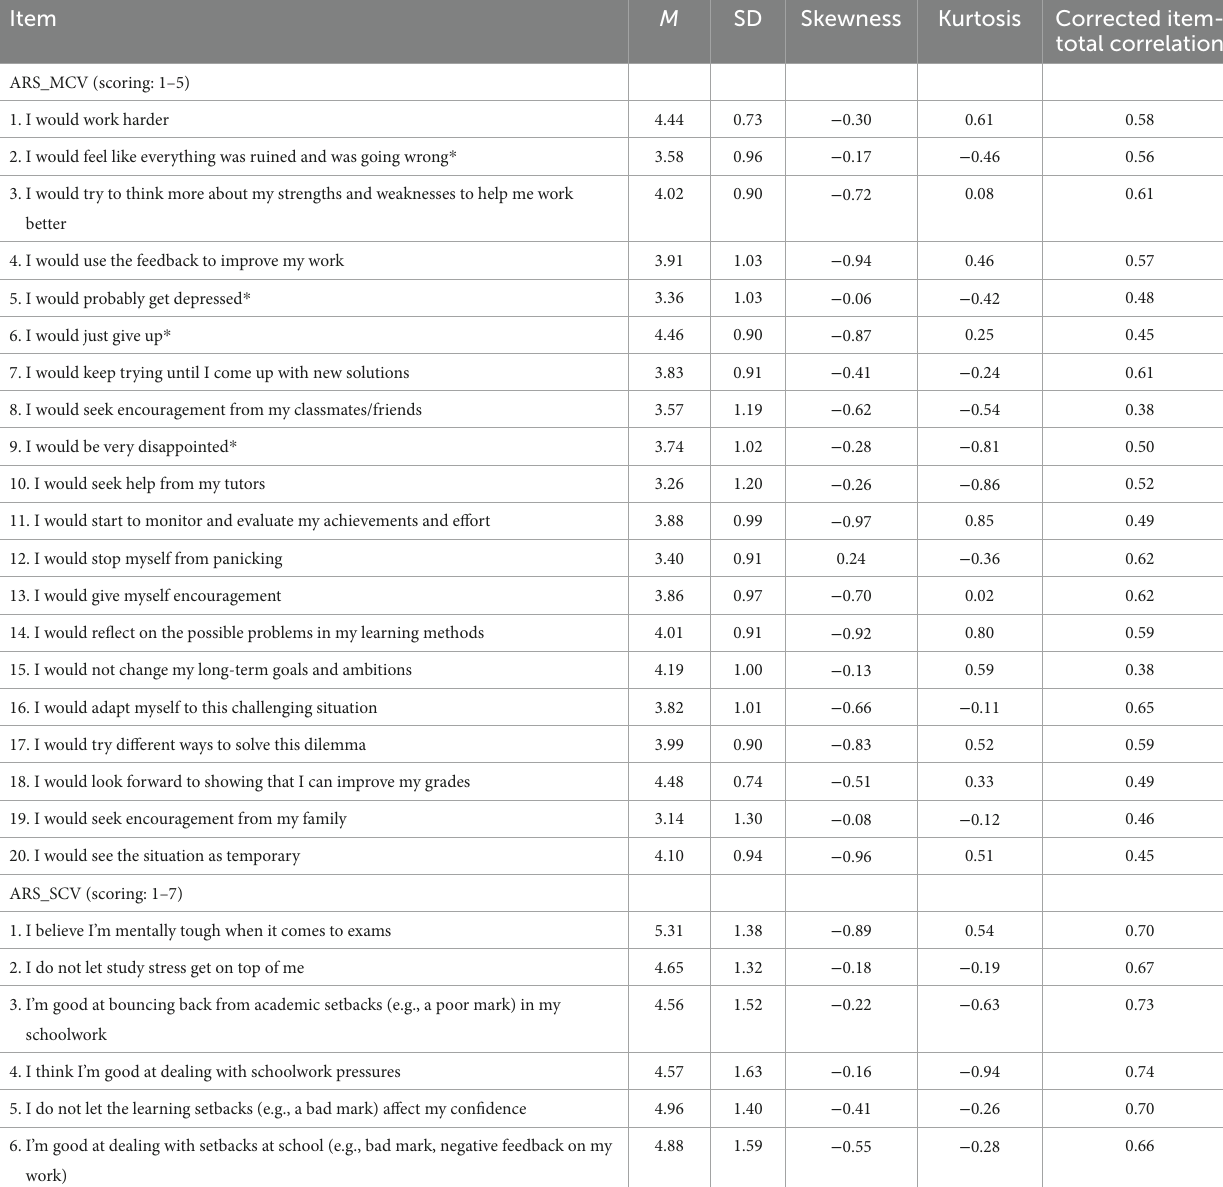
TABLE 2 Descriptive statistics for academic resilience scale. Item M SD Skewness Kurtosis Corrected item-